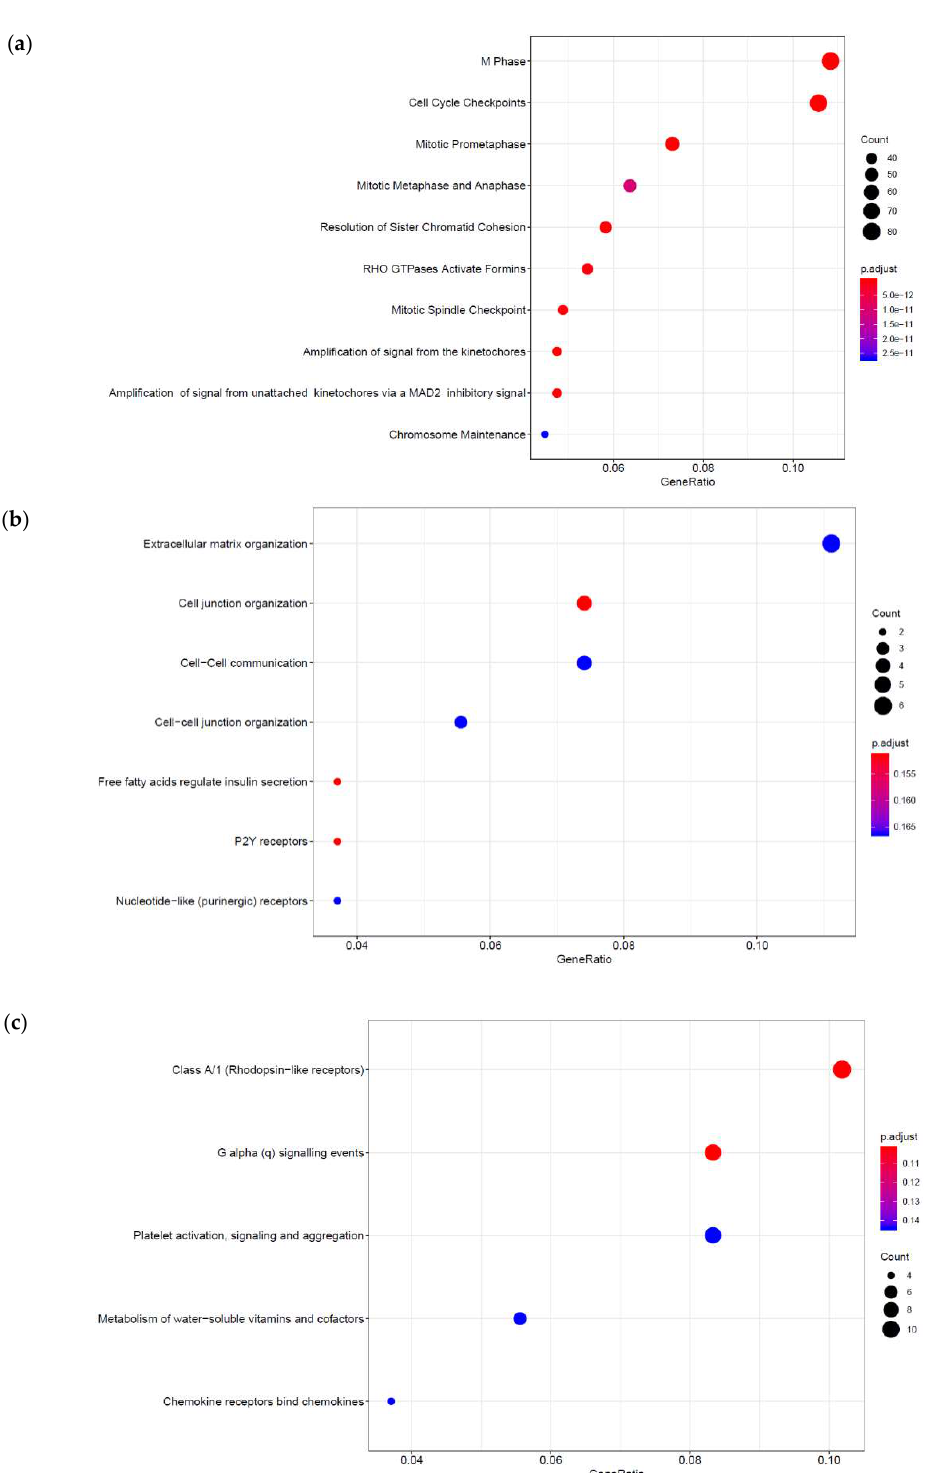
Figure 2. The data forming the Venn data in Figure 1 were analysed by the Bioconductor ReactomePA software package [30] to generate gene ontology (GO; y -axis) maps for significant F / R ( a ), I942 ( b ) and shared ( c ) genes. The x -axis represents the ratio of genes in the ontology over the total number of enriched genes. The occurrence of individual gene ontologies (count) and significance ( p -adjust) are also displayed, as indicated in the key on the right of the graphs.